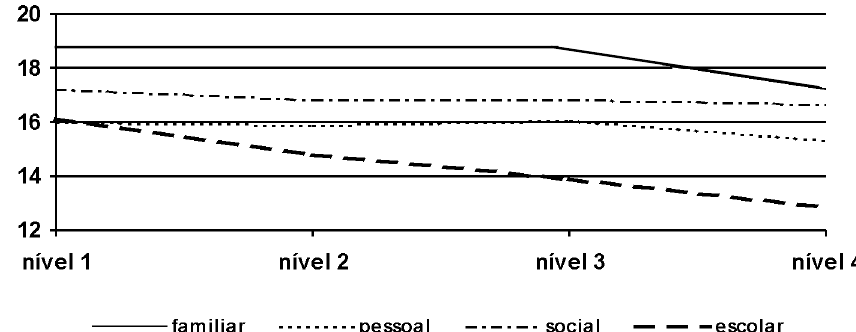
Figura 1 . MØdias dos autoconceitos familiar, pessoal, social e escolar por n(cid:237)veis de dificuldade de aprendizagem na